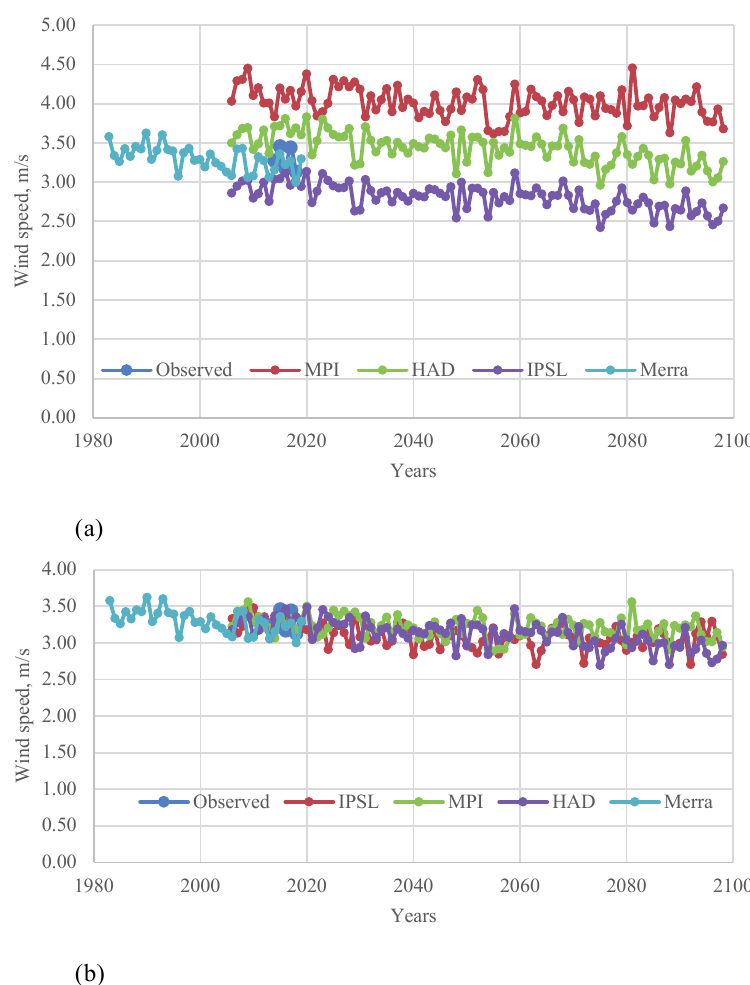
Fig. 1. Comparison of observed, MERRA-2 , and projected annual mean wind speeds (a) before and (b) after bias adjustment according to observed wind speed data for Kaunas HMS. For further analysis, the projected wind speed data for three GCM models were downscaled and then bias-corrected. A comparison of wind speeds for three different projection models and historical wind data is given in Table 1. The meaning of columns is given below the